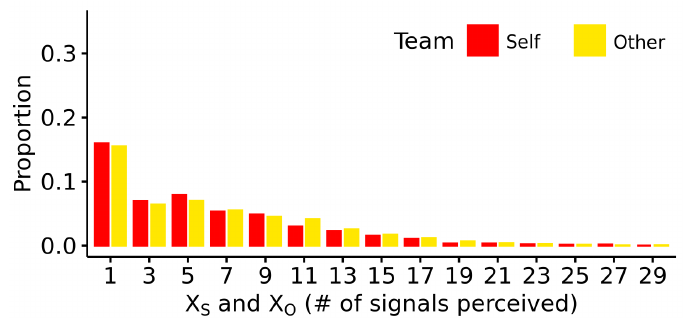
Figure 6. Average perception of a robot observing its neighbors in a mixed aggregate. The number of signals perceived from robots of each team ( X S for self team and X O for opposite team) is highly symmetrical and shows that most frequent observations involve fewer neighbors’ signals. The range and aperture of sensors (field of view) limit the detection of all present neighbors at once. Signals are accumulated in time windows of 10 s, a total of 60,000 observations are represented.